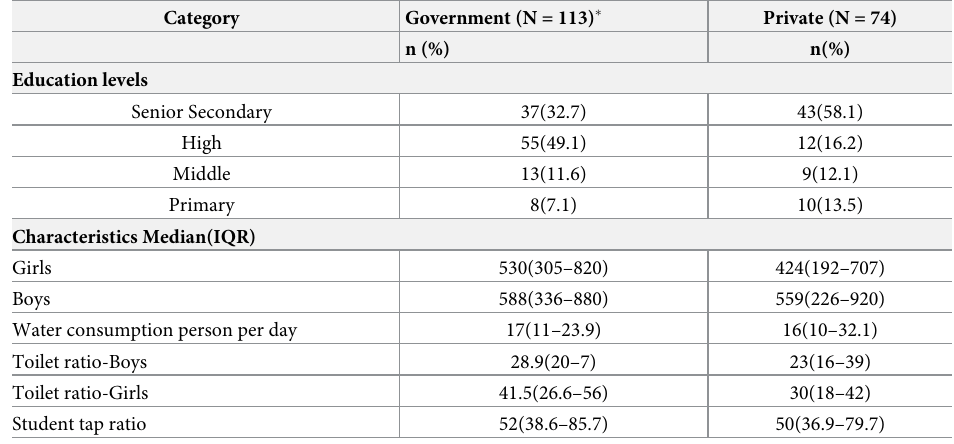
Table 1. Distribution and key characteristics of Government and Private Schools in Chandigarh